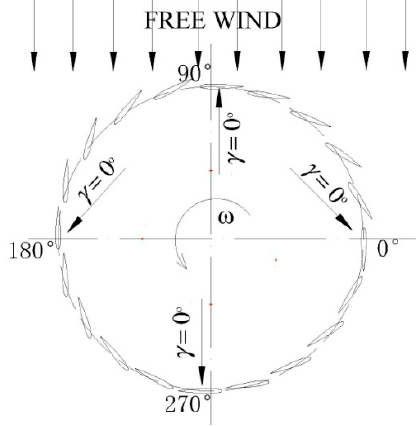
Figure 7. Illustration of new variable pitch.